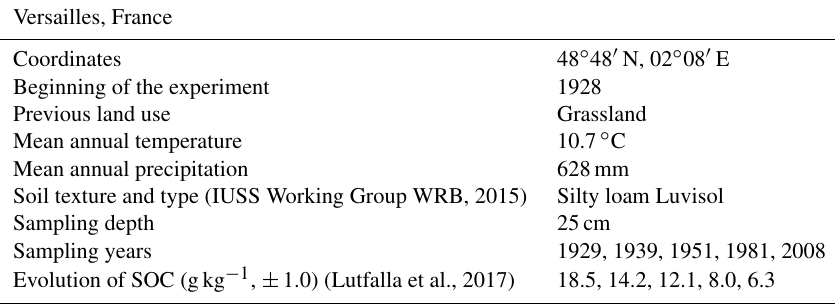
Table 1. Selected characteristics of the Versailles long-term bare-fallow experiment.